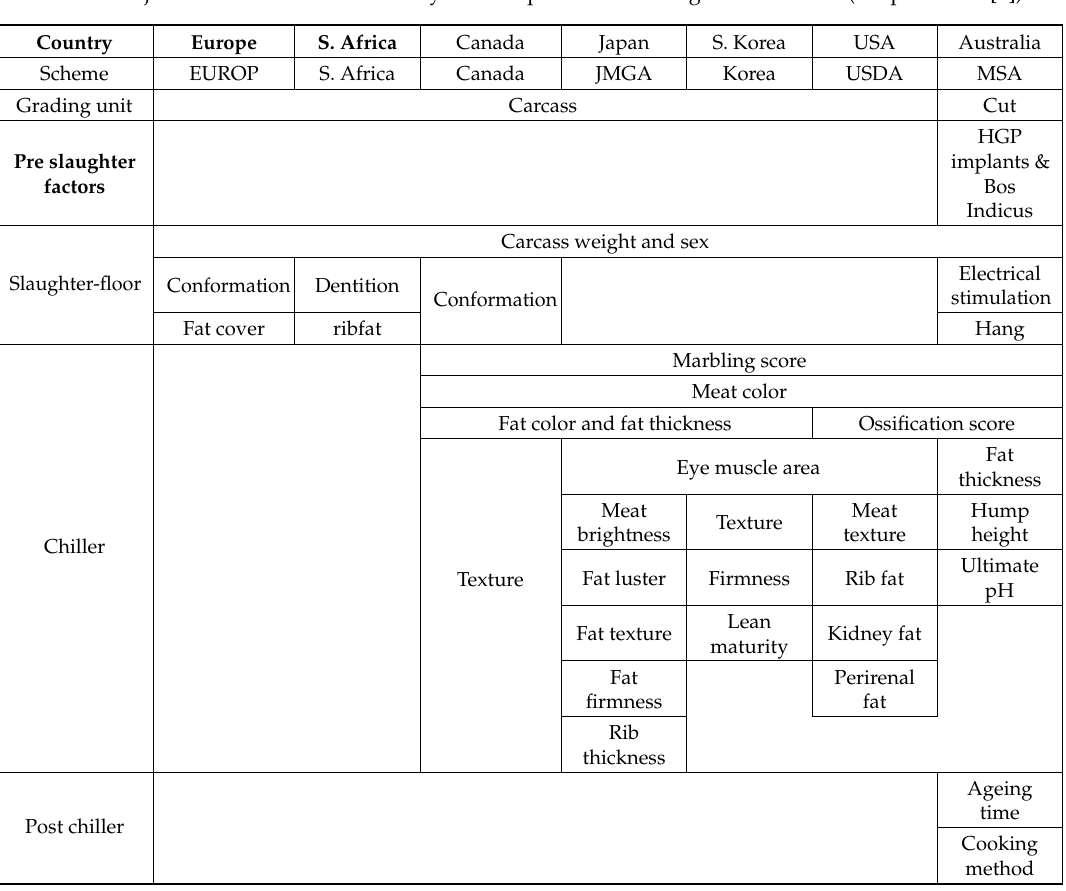
Table 1. Major beef carcass classification systems implemented throughout the world (adapted from